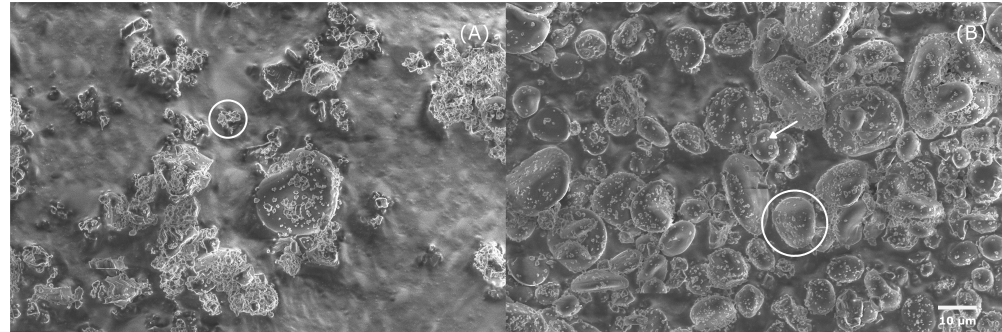
Figure 3. SEM images of separated powders on the cathode ( A ) and anode ( B ) with PVC as charging tube material. On the cathode, small and rugged protein particles (circle left) represent the main fraction. Smooth starch particles (circle right) predominate the population on the anode, while small protein particles adhere on the surface of large starch particles